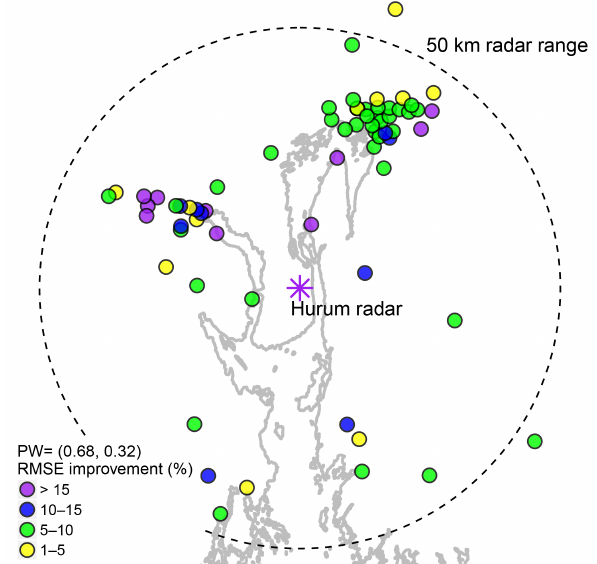
Figure 4. Box plot representing three quality metrics (RMSE, MAE and ME) estimated at gauge locations for the original data (MP) and for the two non-parametric models ( k -nn-R and k -nn-RT). Here, k -nn-R denotes the non-parametric model with radar precipitation rate as a single predictor, while k -nn-RT denotes the non-parametric model with radar precipitation rate and air temperature as two pre- dictors with a fixed partial weight (0.68 and 0.32). The values out- side 1.5 × IQR are represented by the